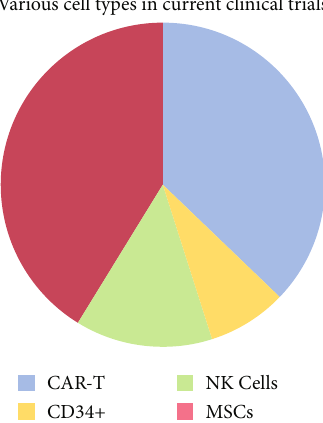
Figure 1: Current Clinical trials on exploring various types of stem cell or cell therapies registered on